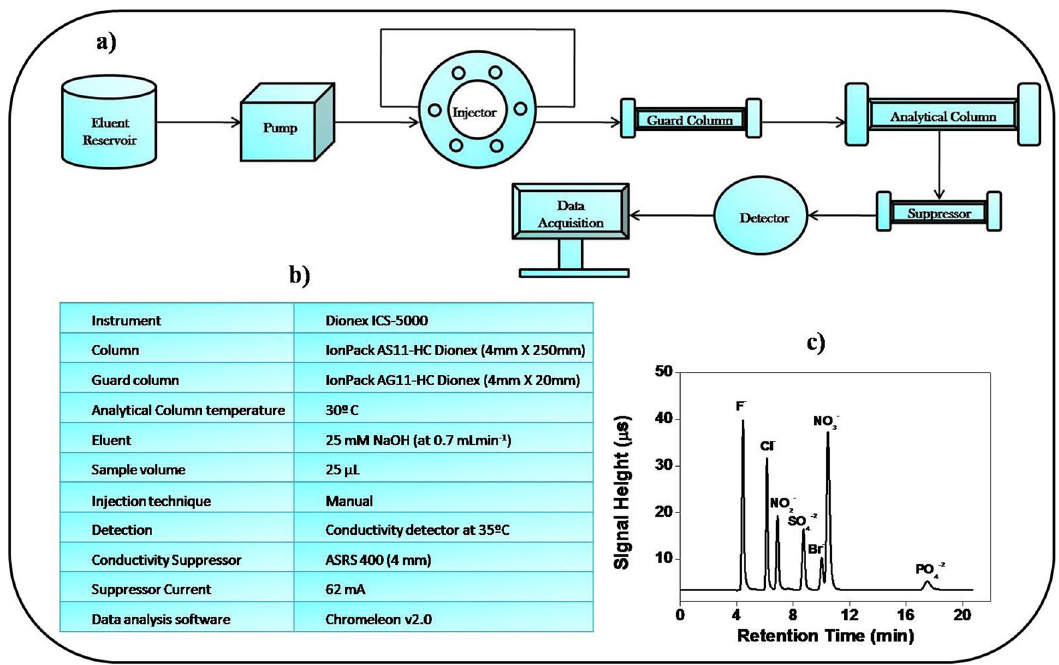
Figure 1: ( a ) Schematic representation of basic components of ion chromatograph with suppressed conductivity detector. ( b ) Ion chro - matographic analysis conditions for separation of seven anions from an aqueous mixture. ( c ) The corresponding chromatogram showing the well - separated seven